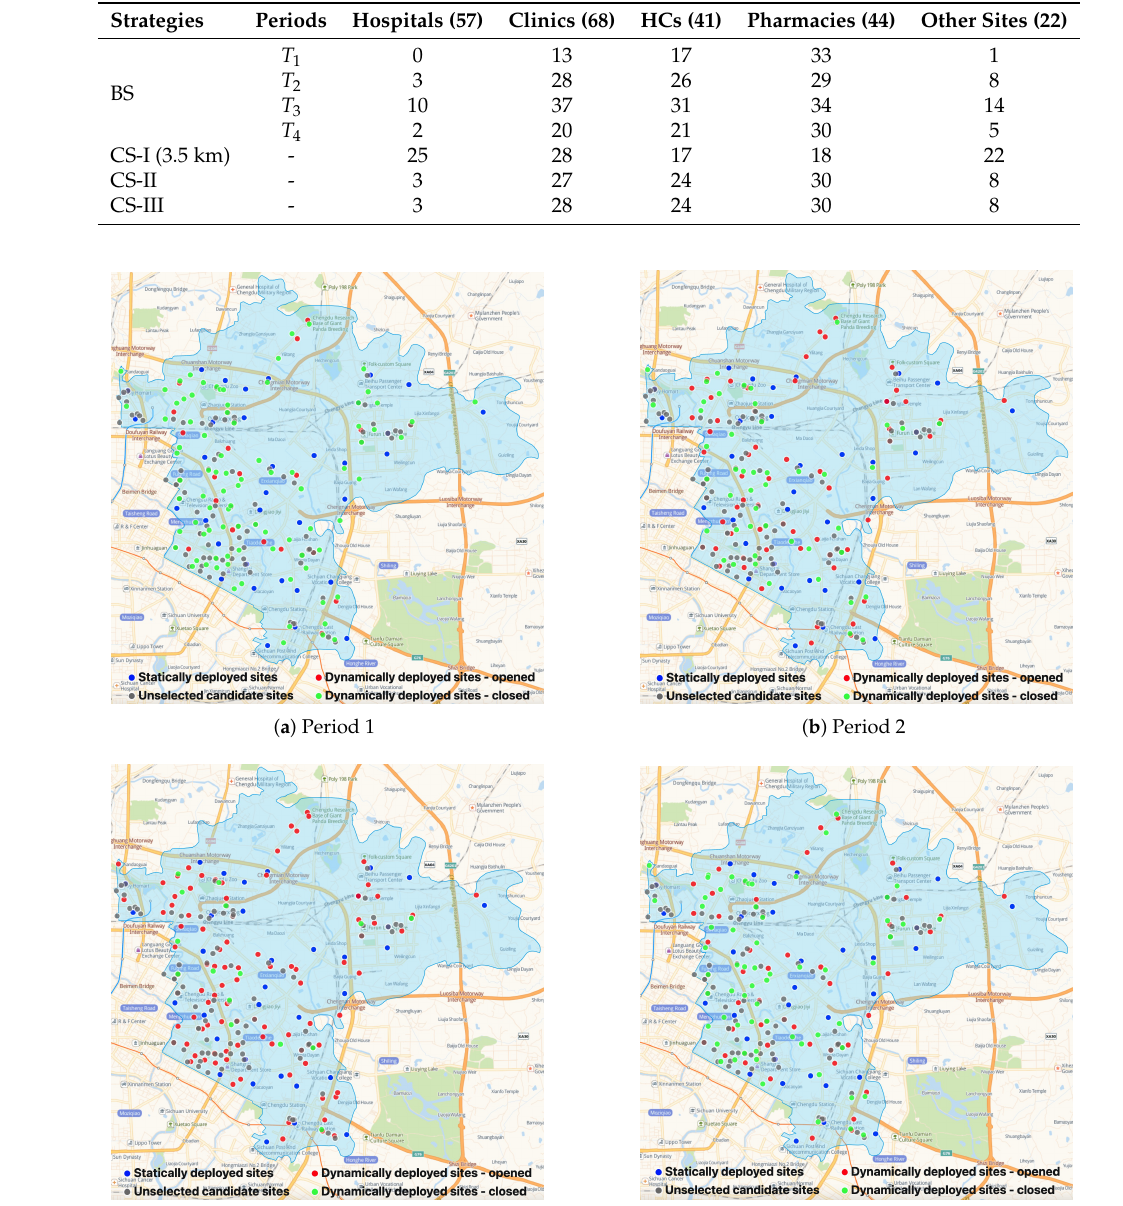
Table 5. The number of various types of sites deployed by various strategies.